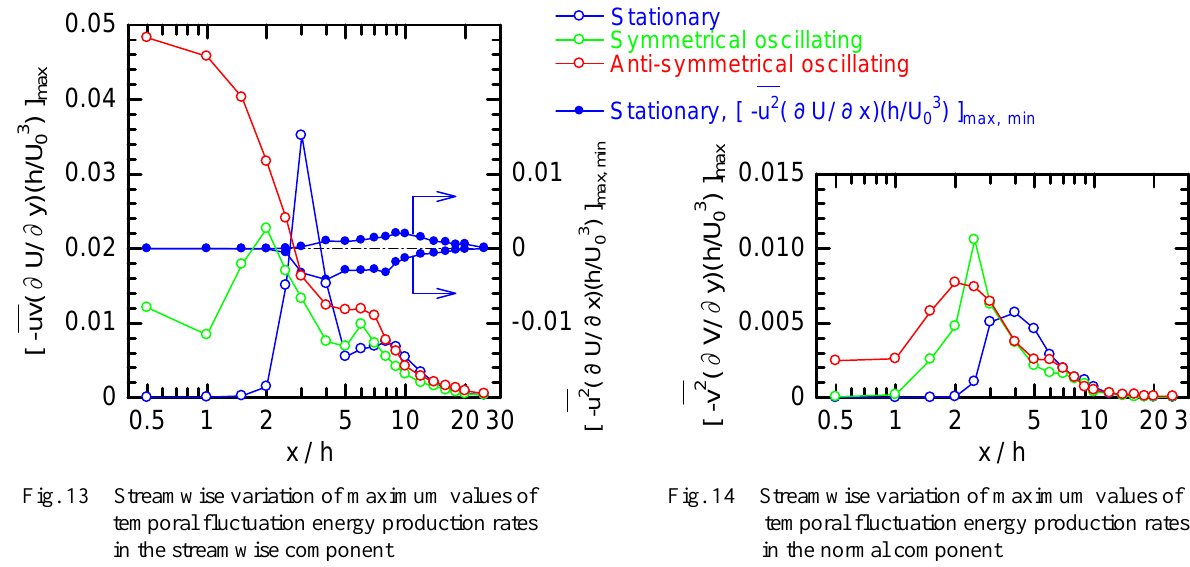
Fig. 13 Streamwise variation of maximum values of Fig. 14 Streamwise variation of maximum values